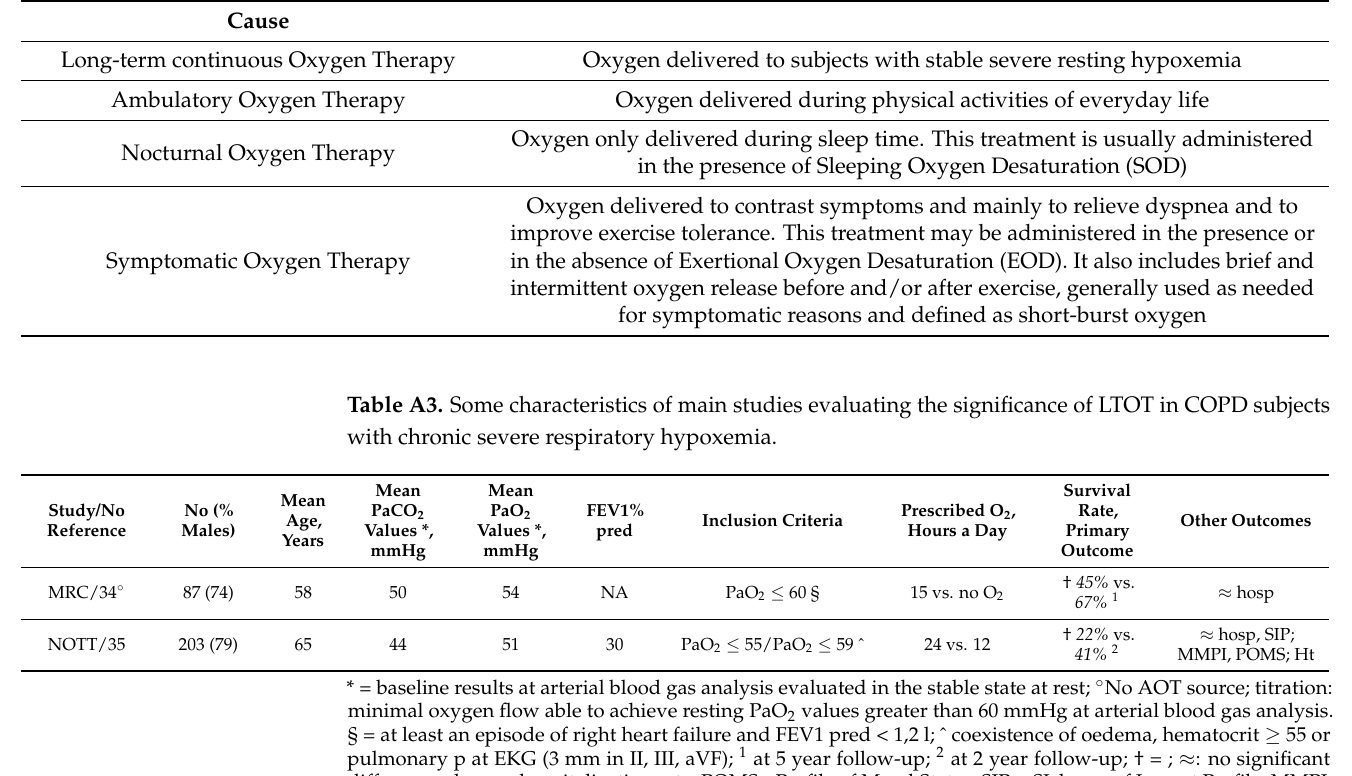
Table A2. Main motivations of Home Oxygen Therapy prescription.